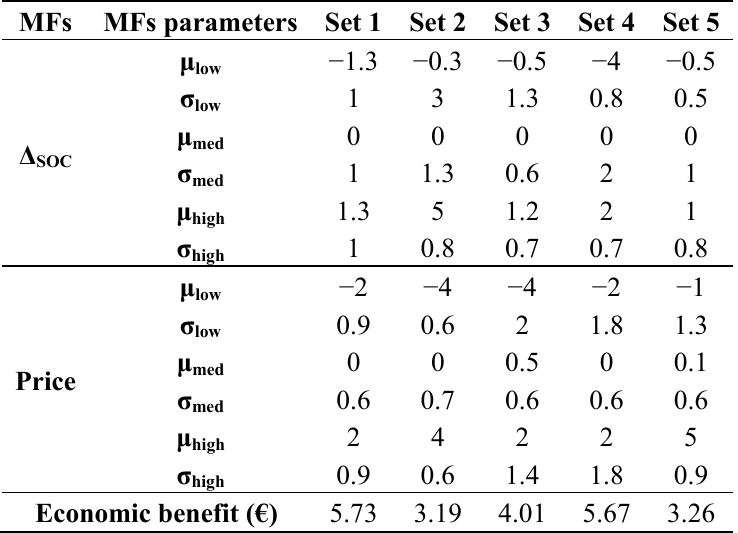
Table 2. Economic benefit with static parameters—stable